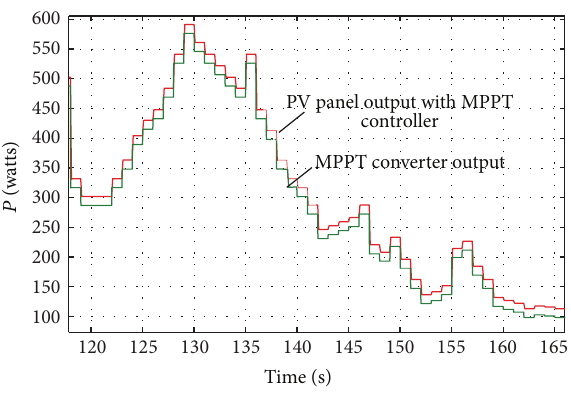
Figure 9: Output of MPPT converter.